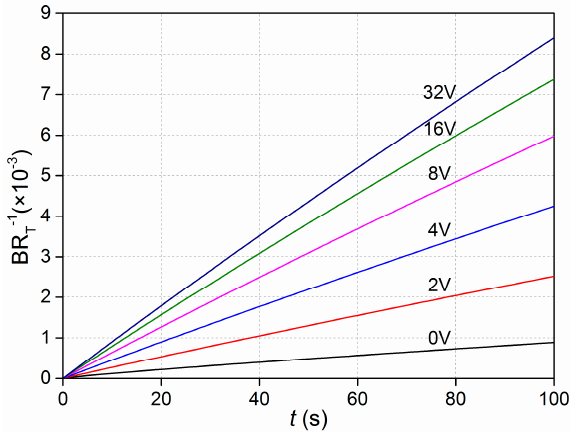
Figure 3. Normalized binding curves for non-enhanced (0 V) and ICEO enhanced (2 V, 4 V, 6 V, 8 V, 16 V, 32 V) transport. B is the amount of analyte bound, which is normalized by the concentration of immobilized antibodies, R T .